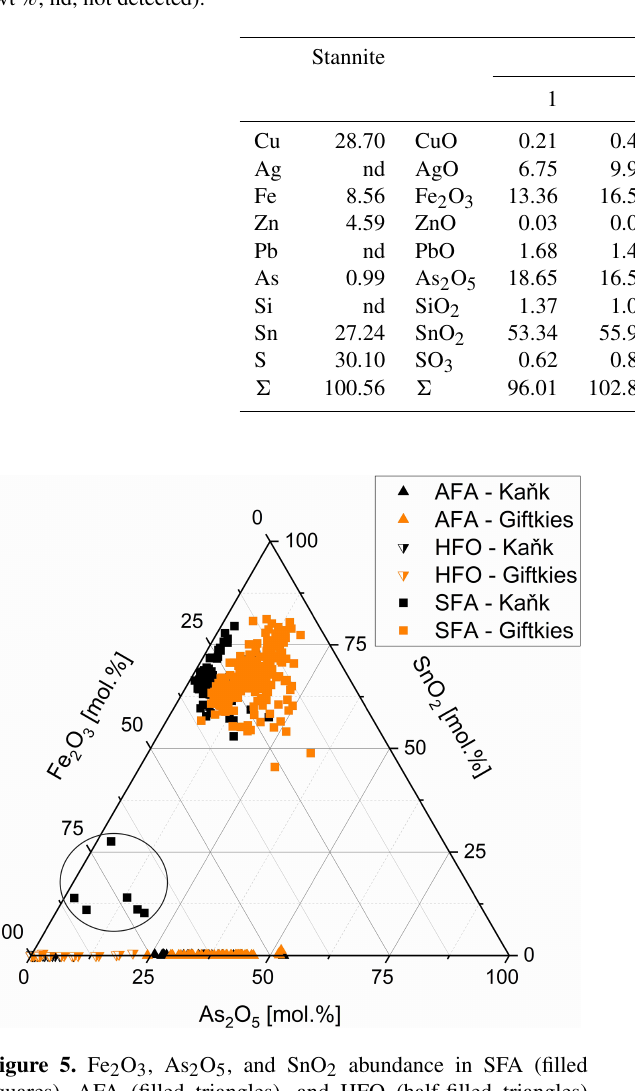
Table 4. WDX analyses of stannite and SFA observed in the weathered stannite grain from Giftkies. Values are given in percent by weight (wt%; nd, not detected).